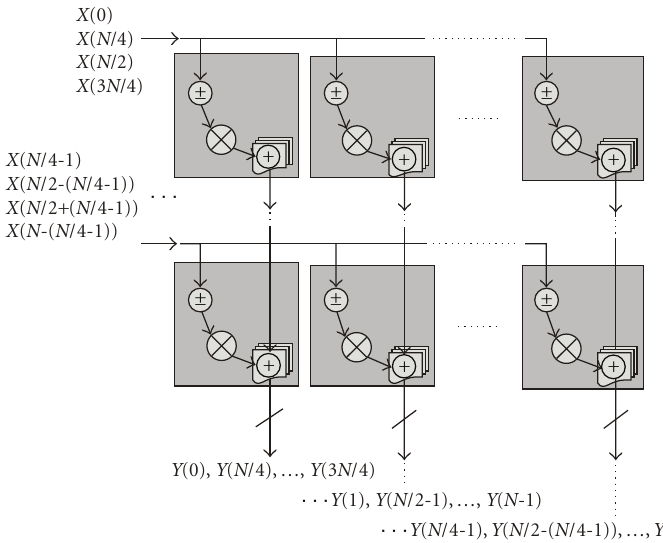
Figure 1: Systolic array structure for parallel computation of an N -point DFT.